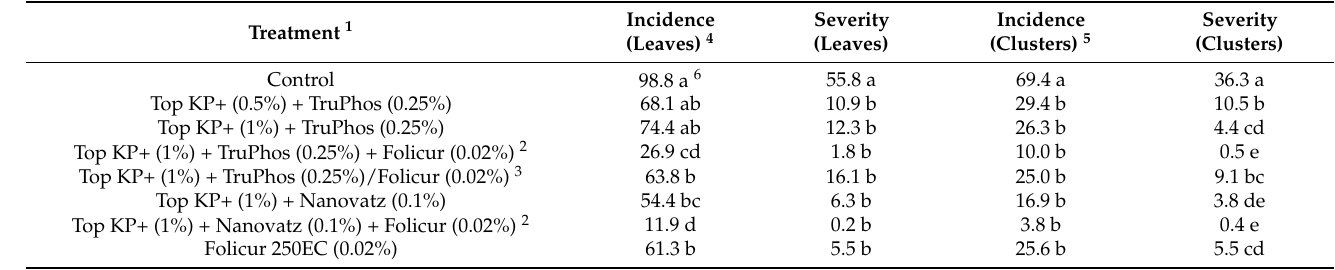
Table 4. Efficacy of nutrients and fungicide in mixtures or alternation in controlling powdery mildew on leaves and clusters of Vitis vinifera cv. Carignan at Mazkeret-Batya vineyard (trial 5), 2020. Treatment